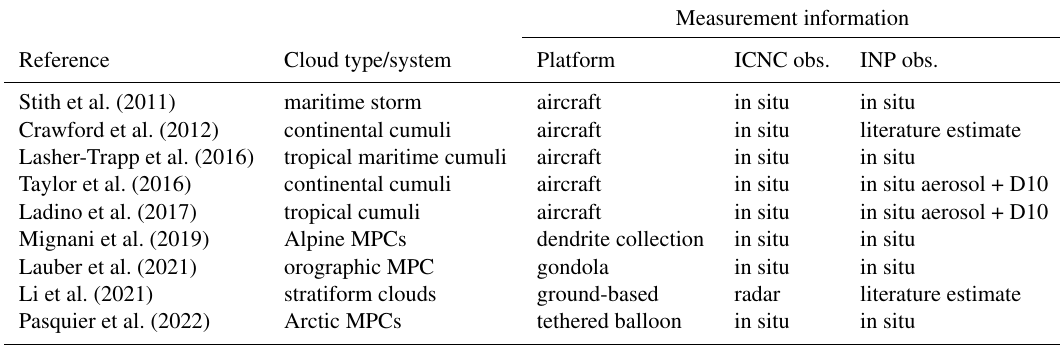
Table G1. Overview of the studies considered in the ice multiplication factor comparison and the corresponding cloud type sampled in the